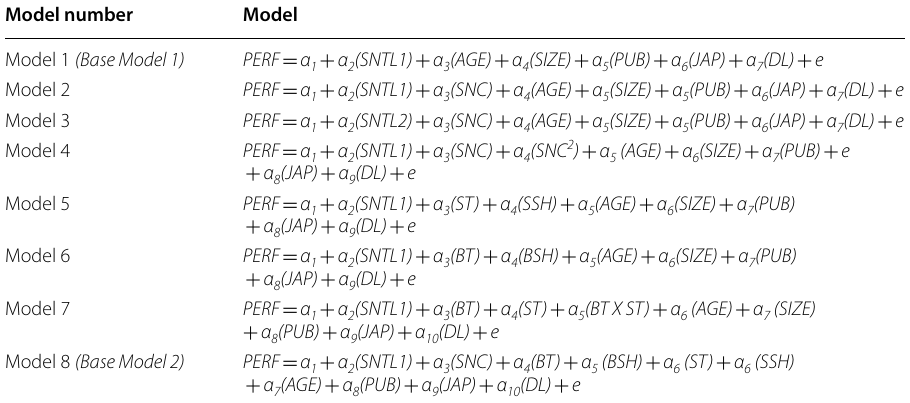
Table 1 Linear regression equations Model